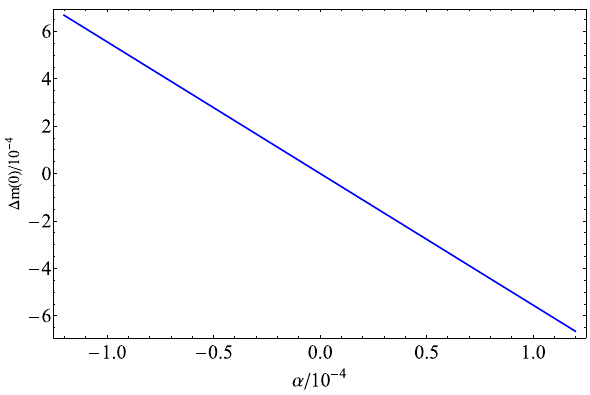
Fig. 8 The relative difference (cid:25) m ( 0 ) as a function of